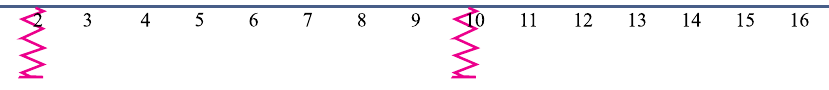
Fig. 5. FEM of the steel bridge